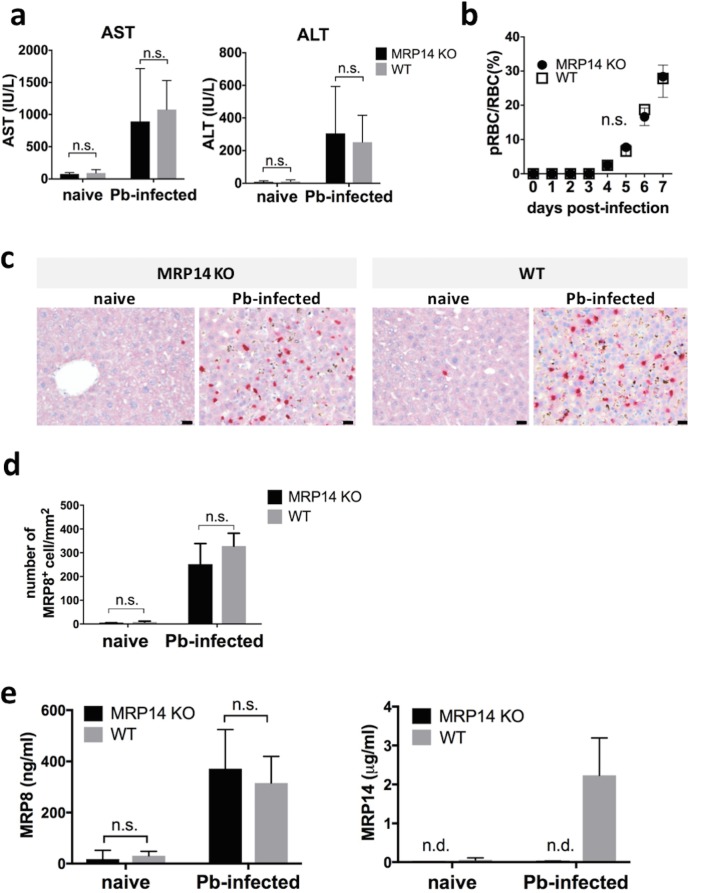
The accumulation of MRP8+ cells independent of MRP14 in the liver during rodent malaria.(a) Serum concentration of AST (left) and ALT (right) of MRP14-KO mice and WT mice after Pb-infection (n = 5). (b) No effect of MRP14 deficiency on parasite proliferation. Kinetics of pRBC rate in peripheral blood after infection of 106 pRBCs in MRP14-KO mice and WT mice (n = 5). (c) The accumulation of MRP8+ cells in the liver of MRP14-KO mice and WT mice after Pb-infection. Bars; 50 µm. (d) The number of accumulated MRP8+ cells in the liver of MRP14-KO mice and WT mice after Pb-infection (n = 5). (e) Serum concentration of MRP8 (left) and MRP14 (right) of MRP14-KO mice and WT mice after Pb-infection (n = 5). Graphs show mean and SD of each group. Data are representative of two independent experiments. *P < 0.05; n.s., not significant.